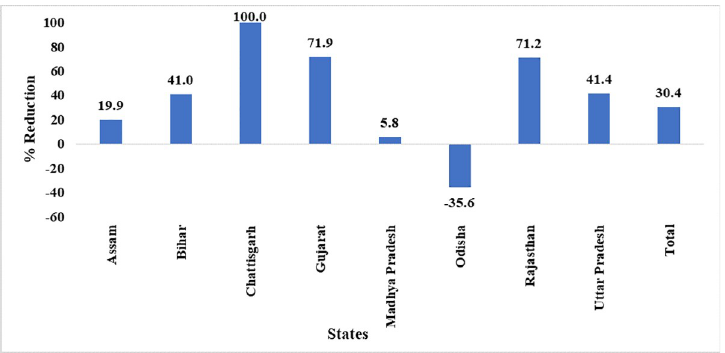
Fig 2. State-wise reduction in vaccine stock-out a . a Data of Jharkhand, Manipur, Nagaland and Himachal Pradesh are not presented as the number of CCPs from these states are less than 30.